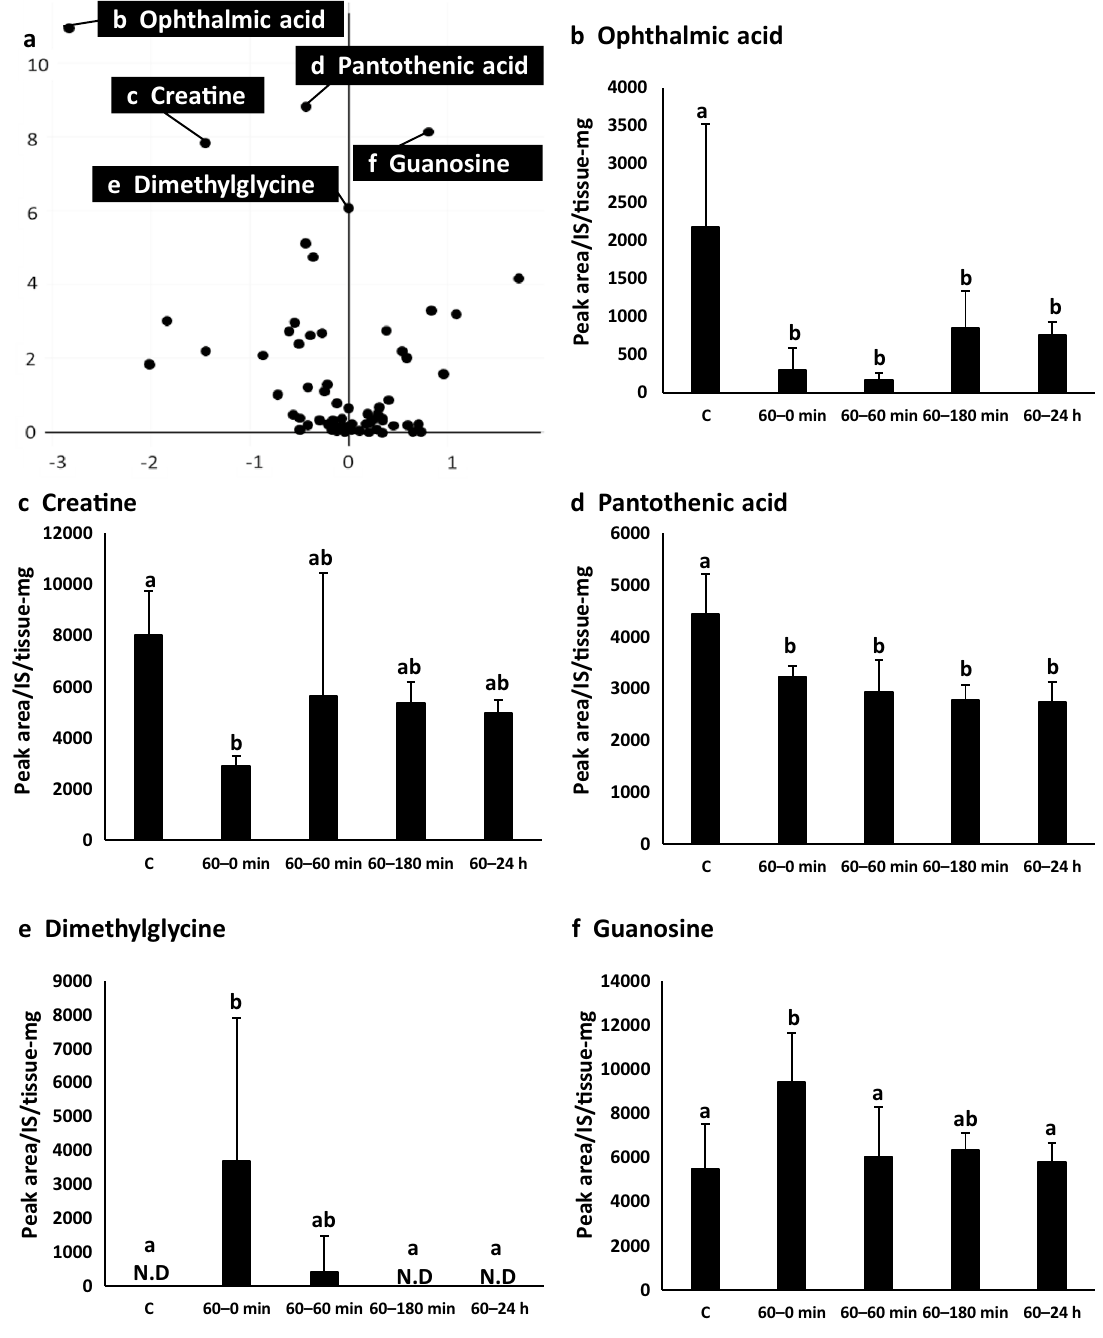
Figure 4. Volcano plot and fluctuating metabolites. (a) Volcano plot (compared with C group and 60–0 min group), (b) ophthalmic acid, (c) creatine, (d) pantothenic acid, (e) dimethylglycine, (f) guanosine. C group (n = 7), 60–0 min group (n = 6), 60–60 min group (n = 6), 60–180 min group (n = 6) and 60 min-24 h group (n = 6). Values with different letters are significantly different (p <